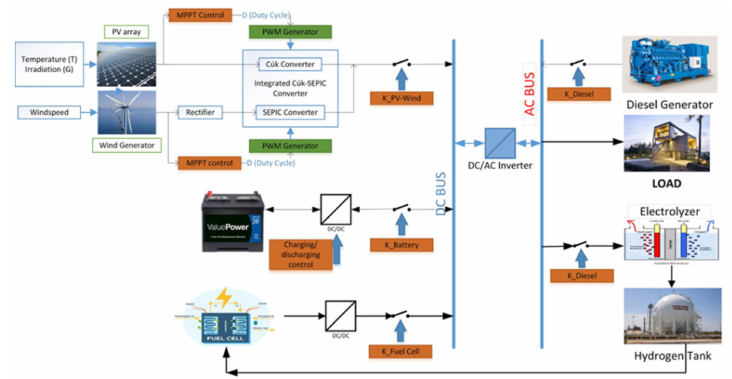
Figure 2. The framework of deep Q-learning.